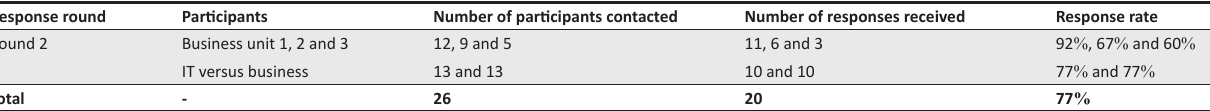
TABLE 2b: Summary of response rates by business unit and background (round